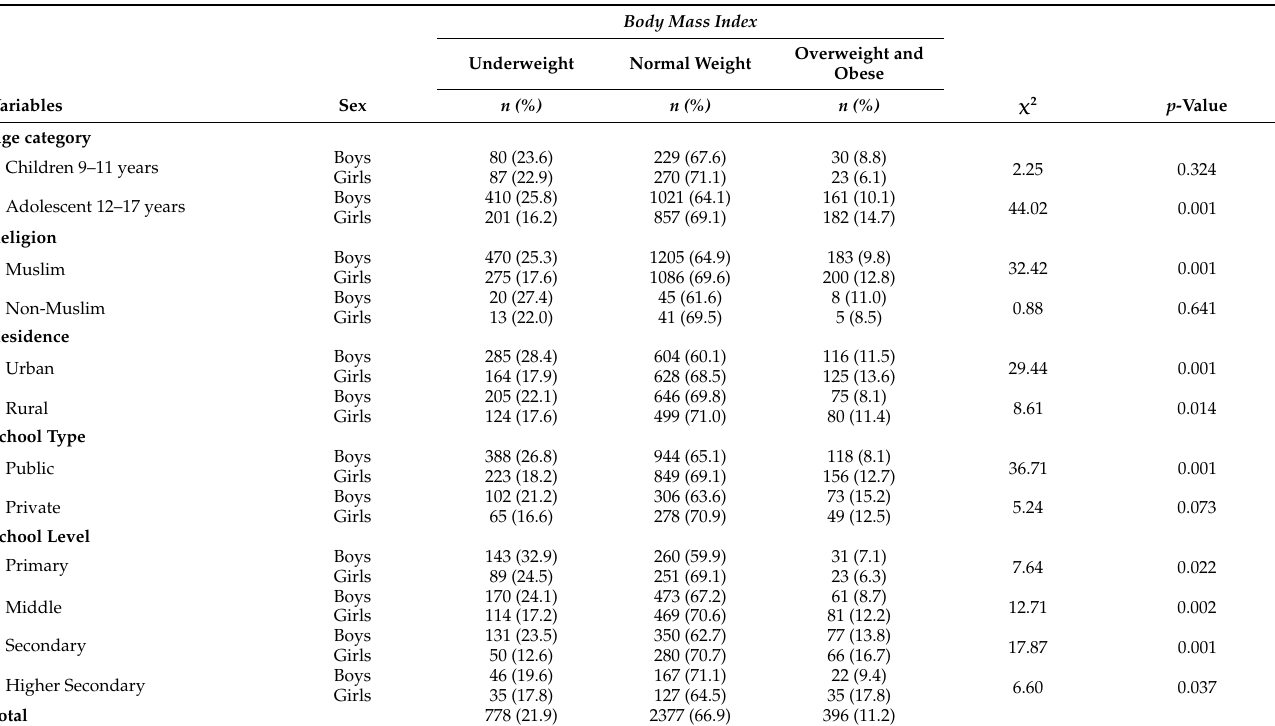
Table 4. Chi-square test to compare the sex-specific prevalence of body weight status with demo- graphic parameters (age, residence, religion, school type, and school